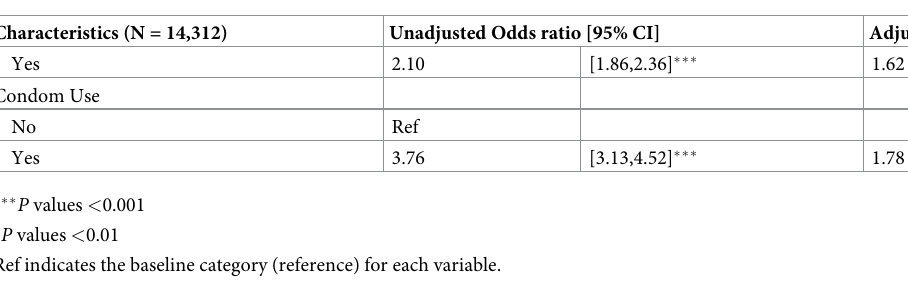
S1 Table. HIV testing by